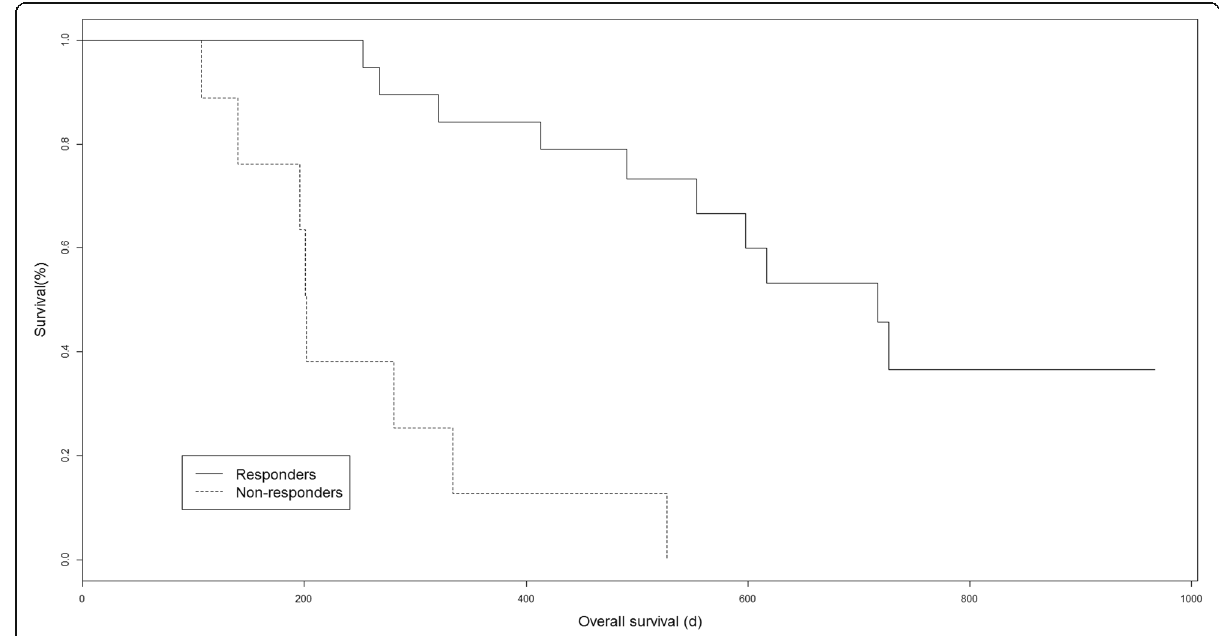
Fig. 5 Kaplan-Meier curves for overall survival for metabolic responders vs non-responders ( p =